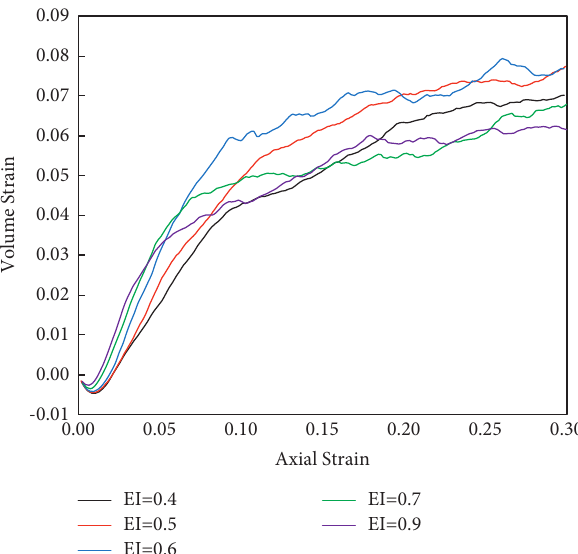
Figure 18: The evolution of volume strain versus axial strain.